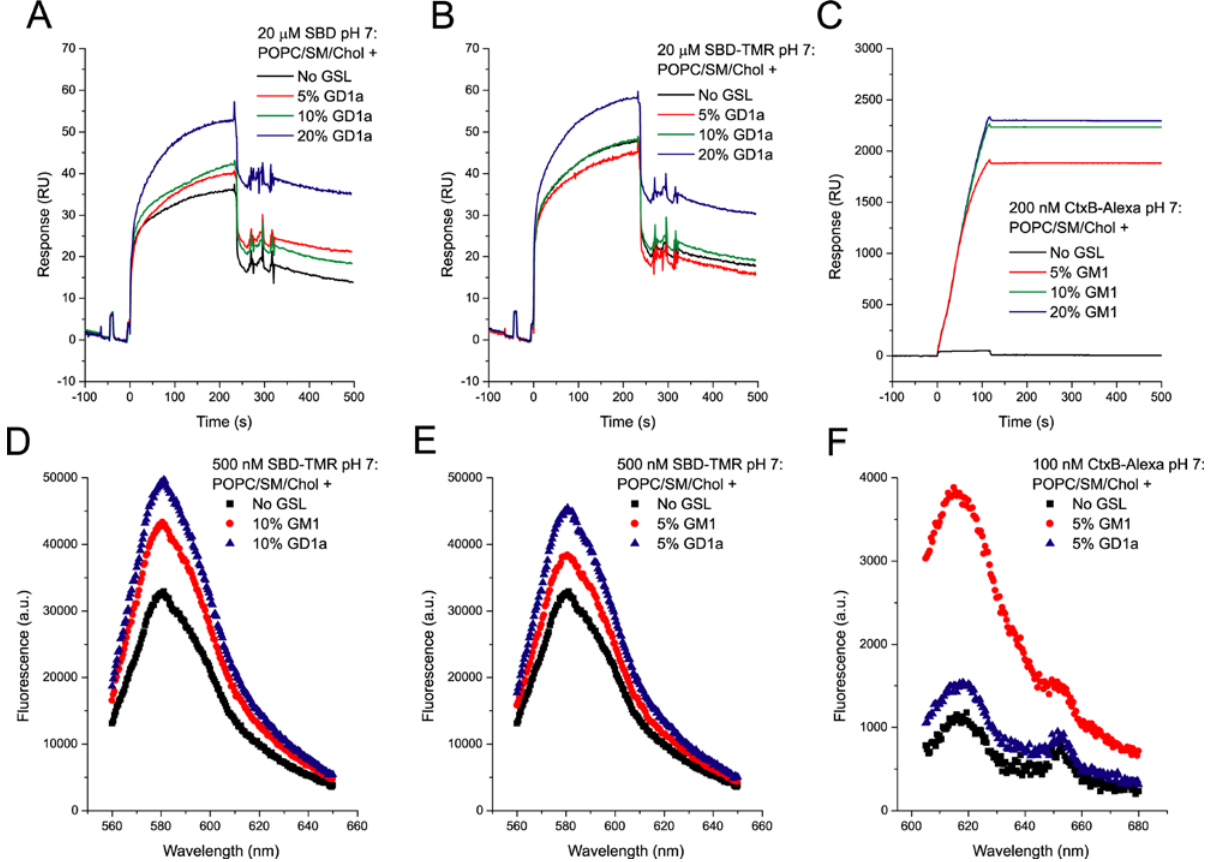
Figure 3. SPR (A–C) and spectrofluorimetric (D–F) binding assays of SBD-TMR to a POPC/SM/Chol (45:25:30 mol%) mixture show that a high concentration of ganglioside (10–20%) is required for optimal binding, by comparison with CtxB to its target, GM1